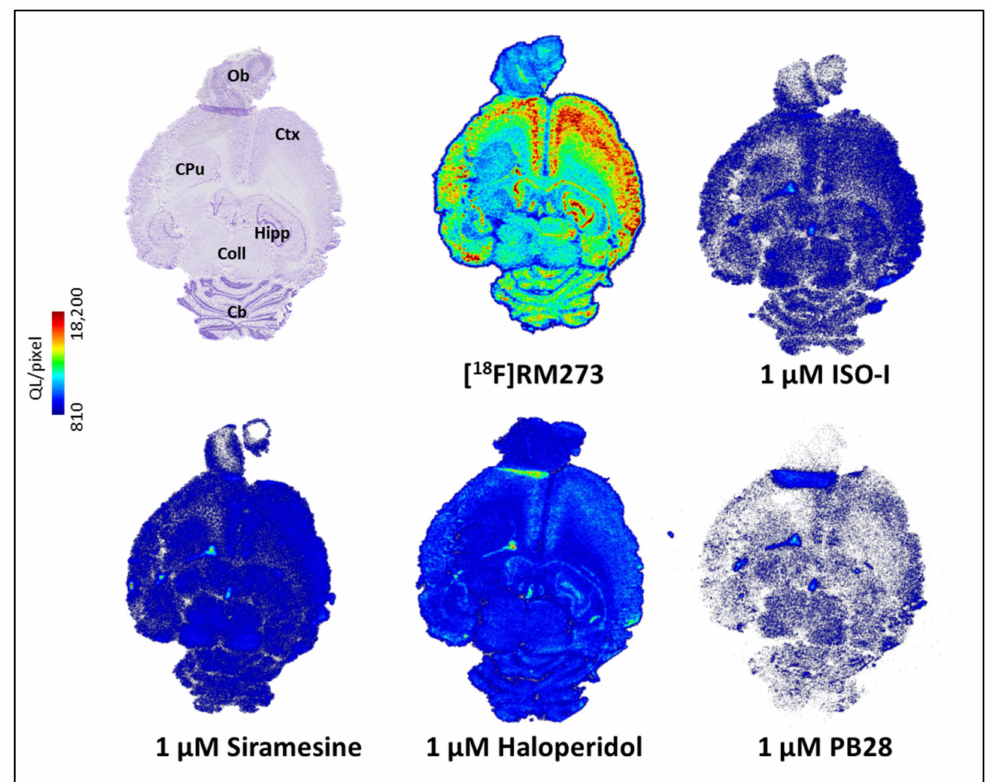
Figure 5. σ 2 receptor-specific binding of [ 18 F] RM273 in the brain. Incubation of cryosections obtained from rat brain with 0.5 nM [ 18 F] RM273 without (total binding) or with co-incubation with different σ 2 receptor-targeting ligands at 1 µ M (ISO-I, siramesine, haloperidol, PB28). For anatomic correlation, Nissl staining was performed. The activity distribution under baseline conditions ([ 18 F] RM273 ) indicates the highest density of binding sites in cortical (Ctx) and hippocampal (Hipp) structures, a medium density in the cerebellum (Cb) and the colliculi (Coll), and a low density in the basal ganglia such as the caudate putamen